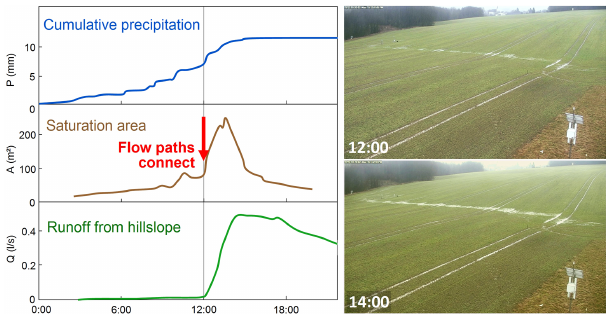
Figure 4. Connectivity of overland flow on 2 March 2015 in the Hydrological Open Air Laboratory (HOAL), Lower Austria. Left: observations of precipitation (at a rain gauge), saturation area (from an analysis of the videos) and runoff (at a flume). Right: video im- ages of the saturation patterns. From Silasari et al.